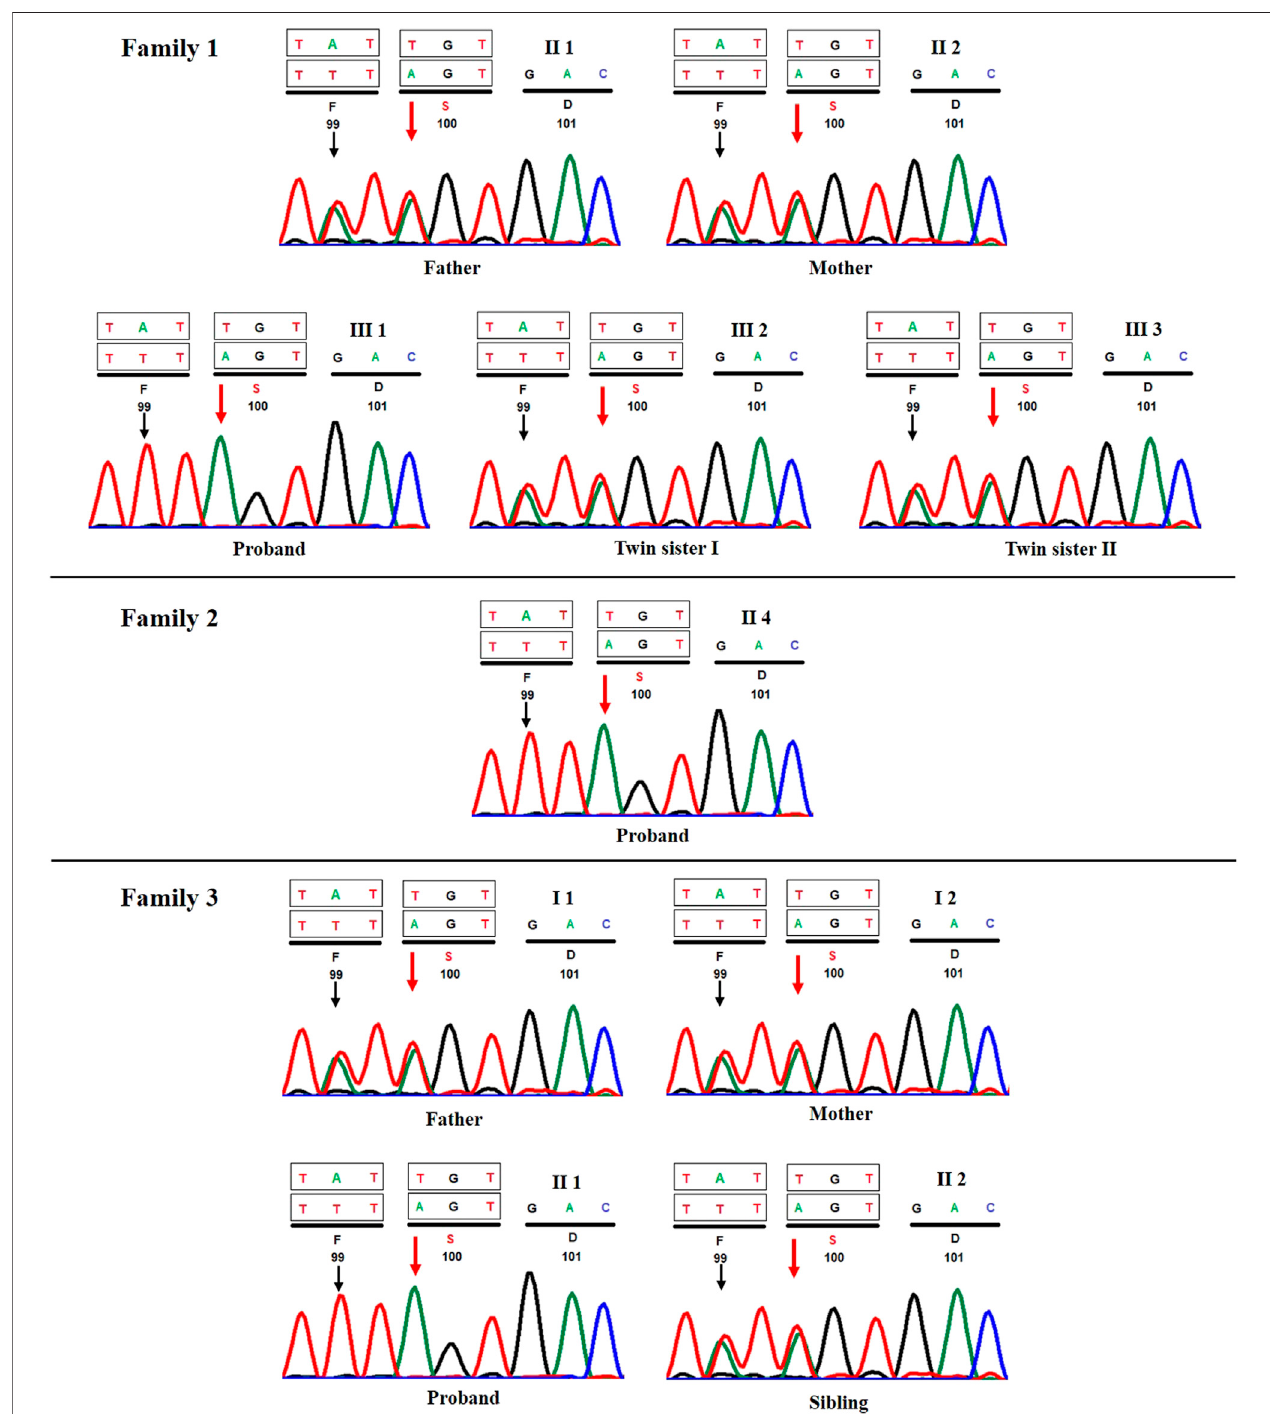
FIGURE 3 | Sanger sequencing chromatograms of all three proband ’ s and their respective fi rst-degree relatives ( A ) case 1, ( B ) case 2, and ( C ) case 3. Red and black arrows show the position of c.298T > A and c.296A > T variants, respectively.